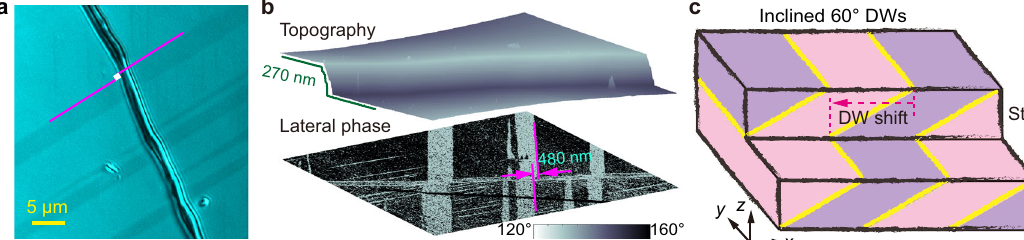
Fig. 7 Inclined 60° DWs owing to the 3D stacking in 3R β ’ -In 2 Se 3 . a Polarized-light image showing the domain wall shift at the top surface across a step edge. b AFM topography and lateral PFM phase images of the area in a . The large in-plane piezoresponse in 3R β ’ -In 2 Se 3 gives domain contrast in the lateral PFM phase image, which is not visible in the corresponding AFM image. The measured height change at the step edge is ~270nm and the wall shift at the top surface is ~480 nm. c Schematic drawing illustrating the shift of the intersection lines between the inclined 60° DWs and the top surface, across a step edge in 3R β ’ -In 2 Se 3 fl akes up to 300 °C. The thickness of the exfoliated sample fl akes is usually 25 − 150 nm. Ultrathin β ’ -In 2 Se 3 fl akes were grown by the chemical vapor deposition (CVD) method. Speci fi cally, Se and In 2 O 3 powders were used as the raw materials and they were placed at separate quartz boats in a dual temperature zone tube furnace. The Se source was placed in the upstream under a 10% H 2 /Ar mix carrier gas at a fi rst heated to 270 and fl owing rate of ~20 sccm. The Se and In 2 O 3 powders were 680 °C respectively and then dwelled for about 30 min, during which thin In 2 Se 3 fl akes were deposited on the mica substrates placed above the In 2 O 3 powders. After the deposition process, the tube furnace was naturally cooled down to room temperature. We discovered that upon naturally cooling the high-temperature β phase (220 − 500°C) with thickness below 400 nm to room temperature, β ’ -In 2 Se 3 always